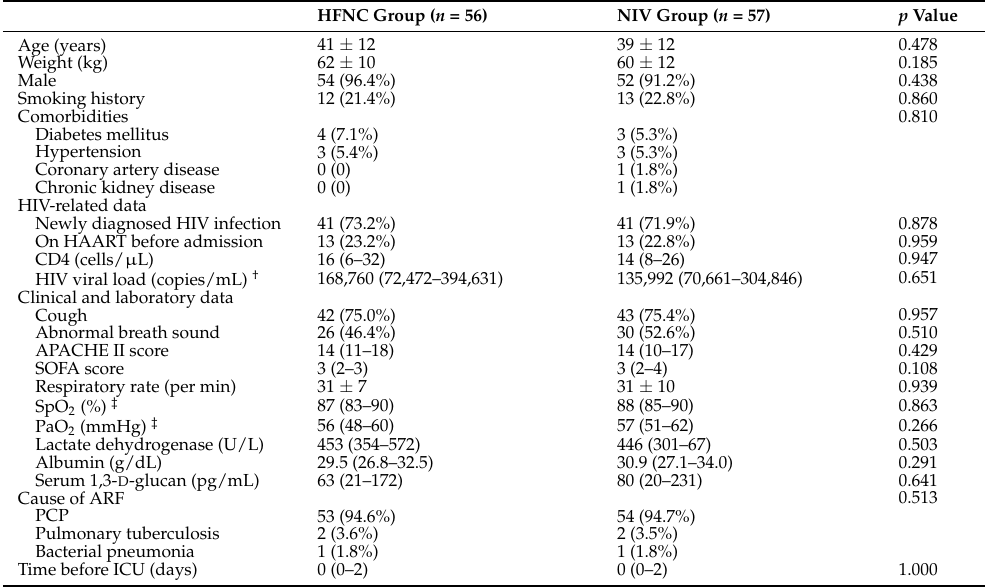
Figure 1. Flow chart of patient enrollment. AIDS, acquired immunodeficiency syndrome; ARF, acute respiratory failure; HFNC, high-flow nasal cannula oxygen therapy; NIV, non-invasive ventilation. Table 1. Baseline characteristics of enrolled AIDS patients.